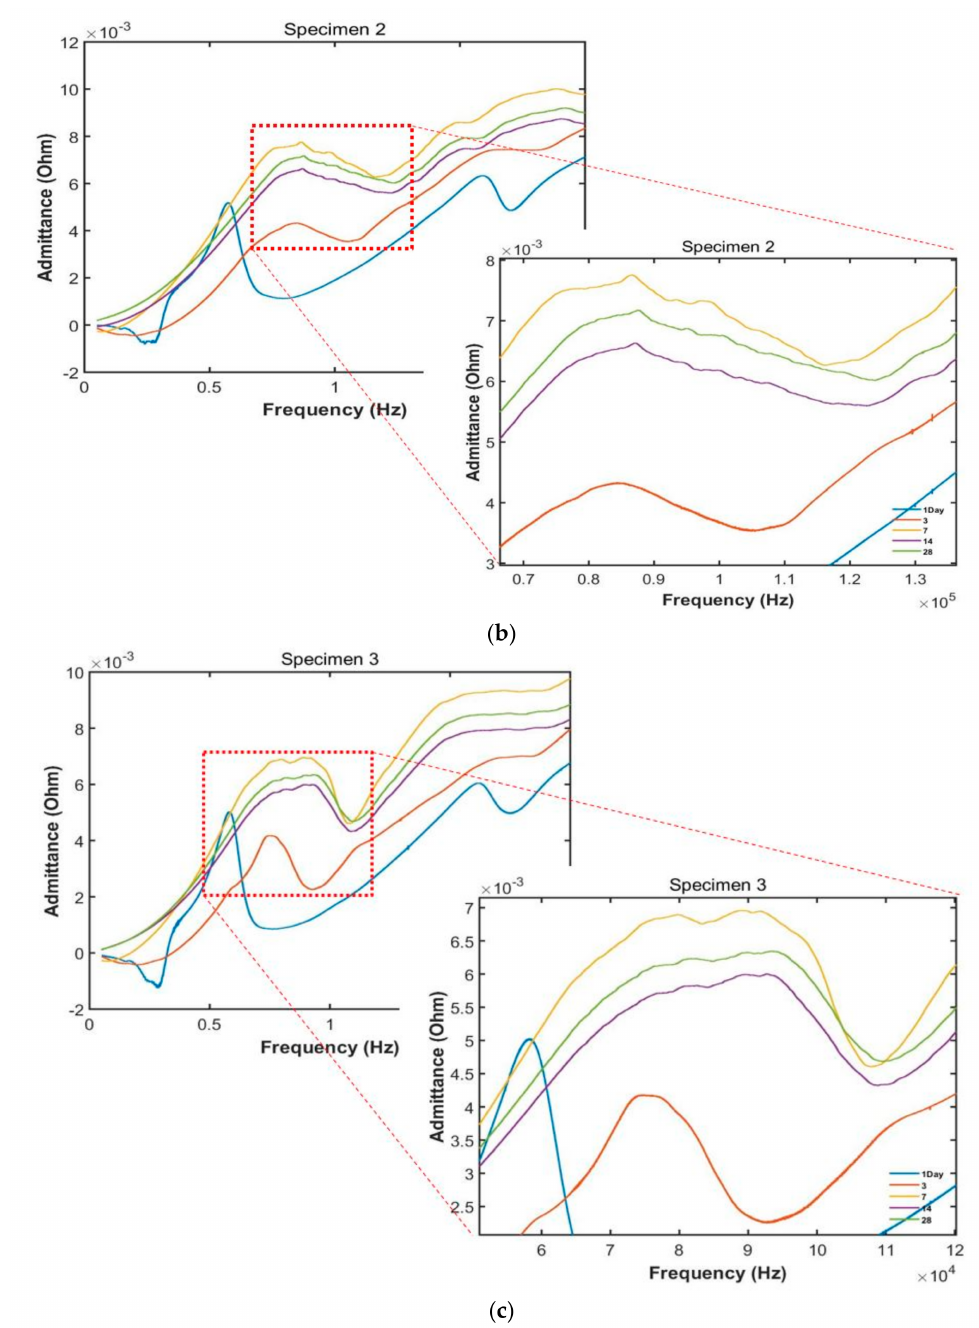
Figure 5. The data measured by sensors in specimens 1, 2, and 3 are represented by ( a – c ), respectively. These data were measured in specimens after cast concrete was aged for between one hour and 28 days. The Figures 6 and 7 shown below depict the cross correlation of impedance data for five different channels over a curing time of 48 h. It can be seen that the amplitude is almost zero after the first hour. After that, until the 18th hour of aging, the amplitude changes and grows rapidly. This indicates a rapid change in the strength behavior. After the 20th hour, the amplitude’s rate of change becomes